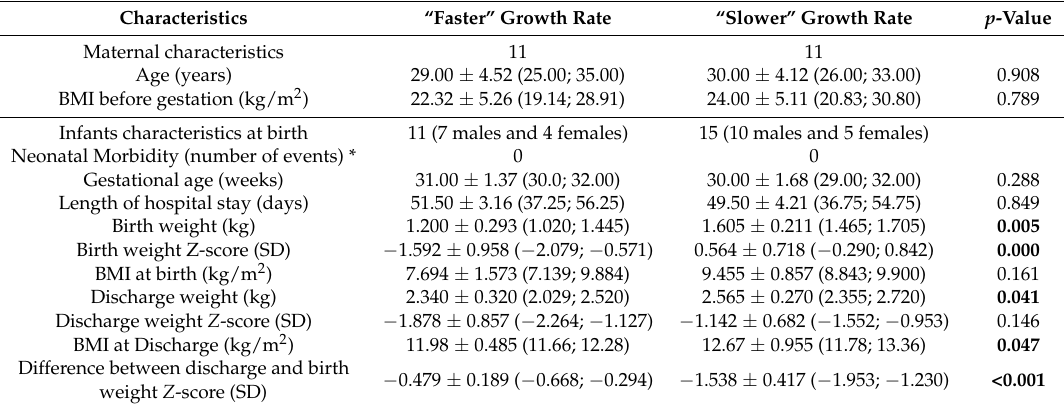
Table 1. Maternal and preterm infants’